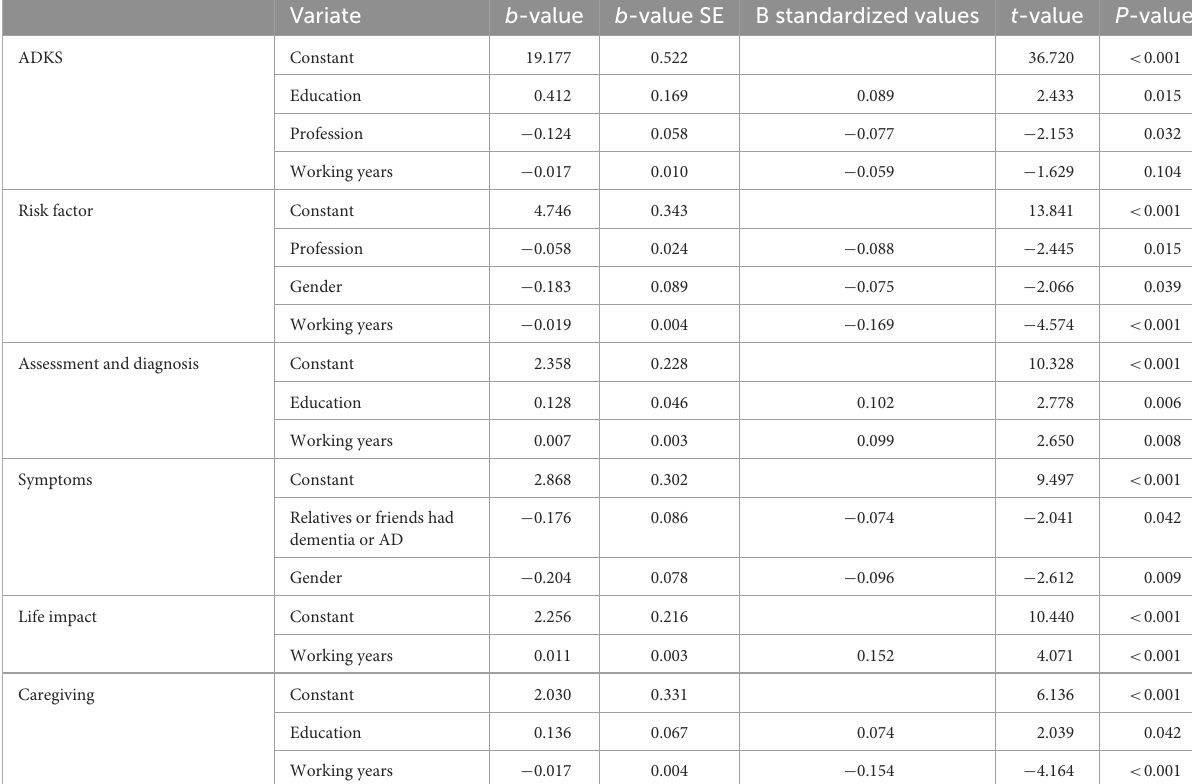
TABLE 2 Multivariate linear regression